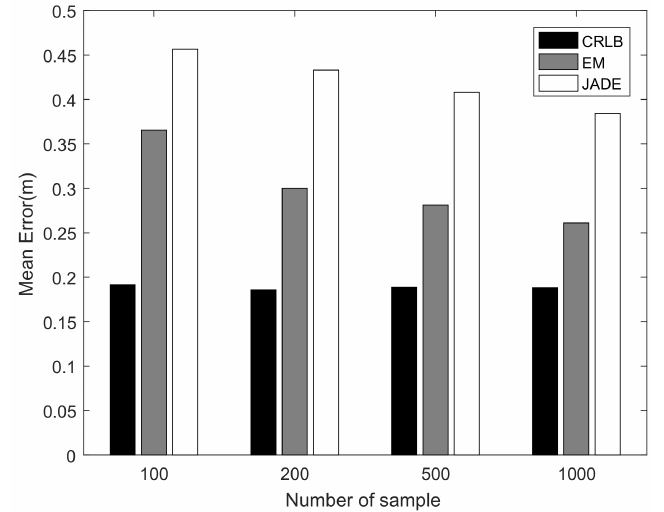
Figure 5. Localization performance versus the number of measured ADOA